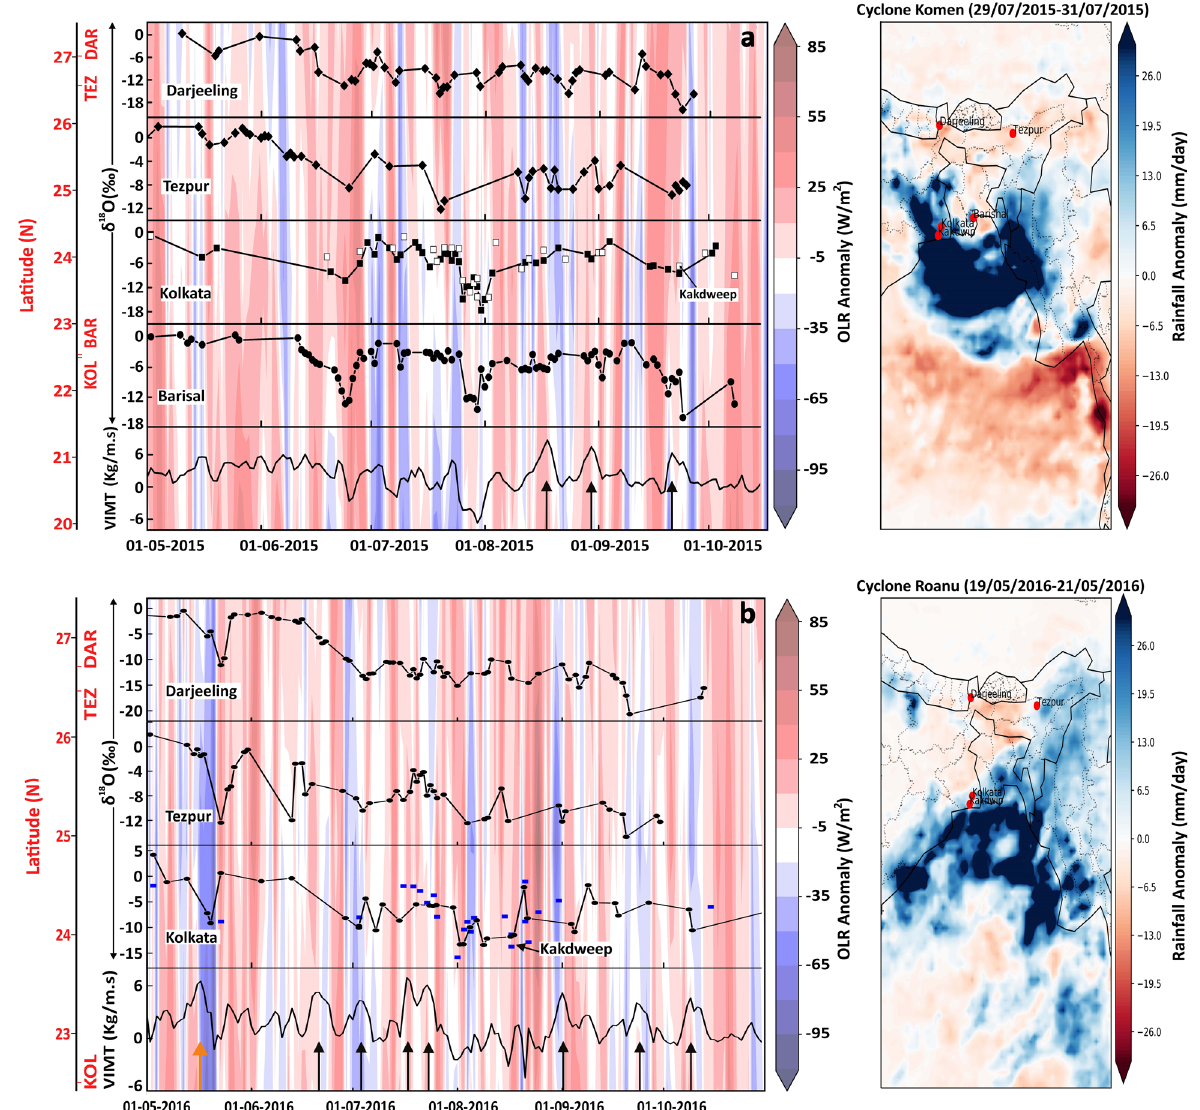
Fig. 5 Precipitation isotopes and convective activity. Relation between the precipitation isotopes (lines) and convective activities (represented by shading; the OLR anomaly) are shown. a The link between the vertically integrated moisture transport/convective events and the precipitation isotopes at four sites, Kolkata, Tezpur, Darjeeling, and Barisal. The Kakdweep data (white boxes) is also shown along with the Kolkata record. The upper right panel shows the rainfall anomaly observed during a cyclonic event ‘ Komen ’ during which high VIMT was found. But the anomaly had little effect either at Darjeeling or Tezpur. b The same as above but for the year 2016. Similar behaviour was observed concerning the control of the VIMT on the precipitation isotopes. A regional-scale convective activity (shown as an orange arrow at the bottom panel) happened soon after a deep depression (Roanu) around May 20 (lower right panel), which caused near synchronous precipitation isotopic depletions in all three